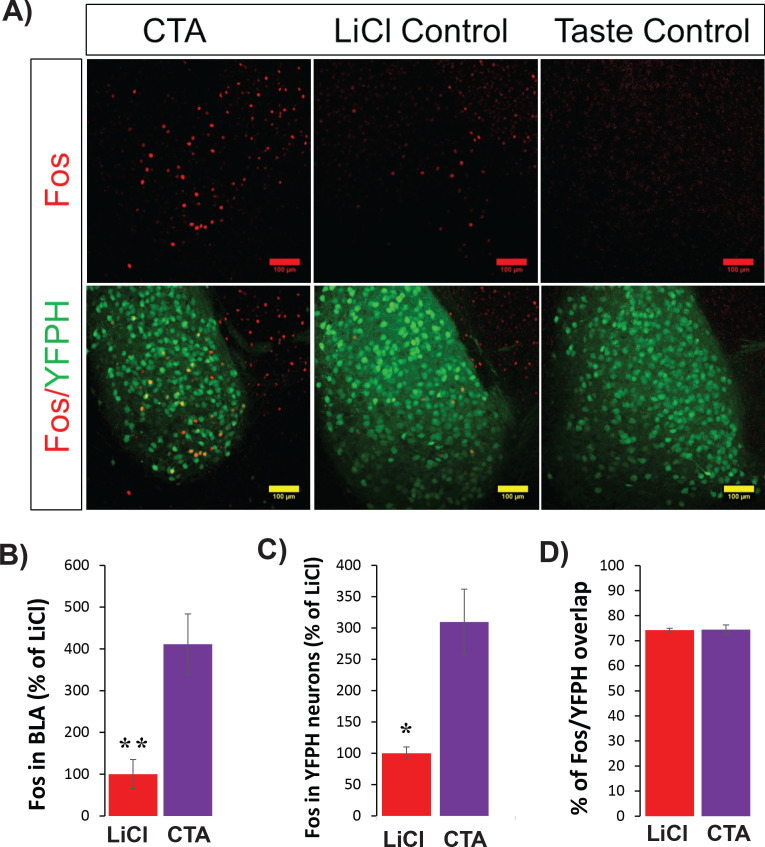
CTA increases C-FOS protein expression in BLApn including those in strain YFP-H.(A) Images of YFP+ neurons in the BLA (green) and C-FOS protein (red) 4 hr following CTA training, LiCl and taste controls. Note that the taste control group has no C-FOS+ signal and so is not shown in B-D. (B) CTA increased C-FOS expression in BLA relative to the LiCl and taste controls (F(2,11)=21.2; p=4×10−4; Post hoc (Bonferroni corrected) difference between CTA and LiCl groups: p=0.003, and p=4×10−4 between CTA and taste control groups, N = 4/group). (C) As in (B), but only for C-FOS overlapping YFP expression (f(2,11)=23.5: p=0.008, post hoc: CTA and taste control groups: p=4×10−4; N = 3–4/group). *p<0.05; **p<0.01. (D) In both CTA and LiCl control conditions, the expression of C-FOS protein was similarly localized to YFP+ neurons (74.4% for CTA and 74.2% for LiCl control). See also Figure 2—figure supplement 1—Source datas 1–2.Figure 2—figure supplement 1—source data 1.FOS protein counts in BLA 4 hr following CTA training and LiCl control.This data relates Figure 2—figure supplement 1 panel B.Figure 2—figure supplement 1—source data 2.FOS protein counts in BLA YFPH+ neurons 4 hr following CTA training and LiCl control.This data relates Figure 2—figure supplement 1 panel C.